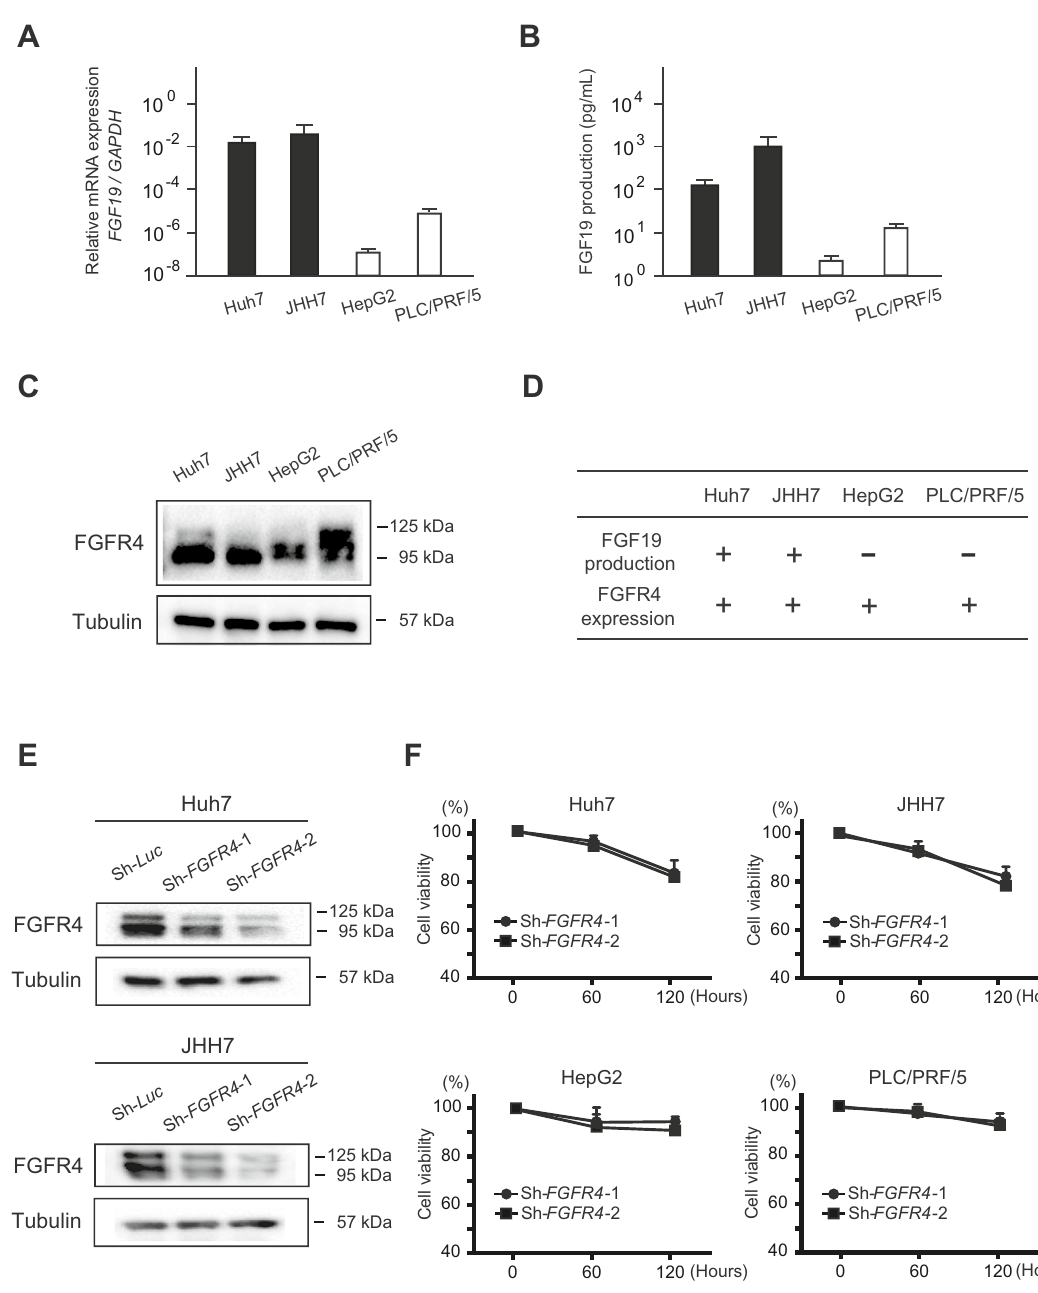
Figure 1. Basal expression of FGF19/ FGFR4 and FGFR4 -knockdown in HCC cells. ( A ) FGF19 mRNA expression in HCC cells. ( B ) FGF19 secretion in HCC cells. ( C ) FGFR4 protein levels in HCC cells. ( D ) Summary of the FGF19/FGFR4 expression pattern in HCC cells. ( E ) Cells transduced with the indicated lentiviruses were subjected to Western blot analyses using anti-FGFR4 antibody and anti-tubulin antibody (loading control). ( F ) Cell growth inhibition in FGFR4 -knockdown HCC cells 60 and 120 h after seeding. These data were from three independent